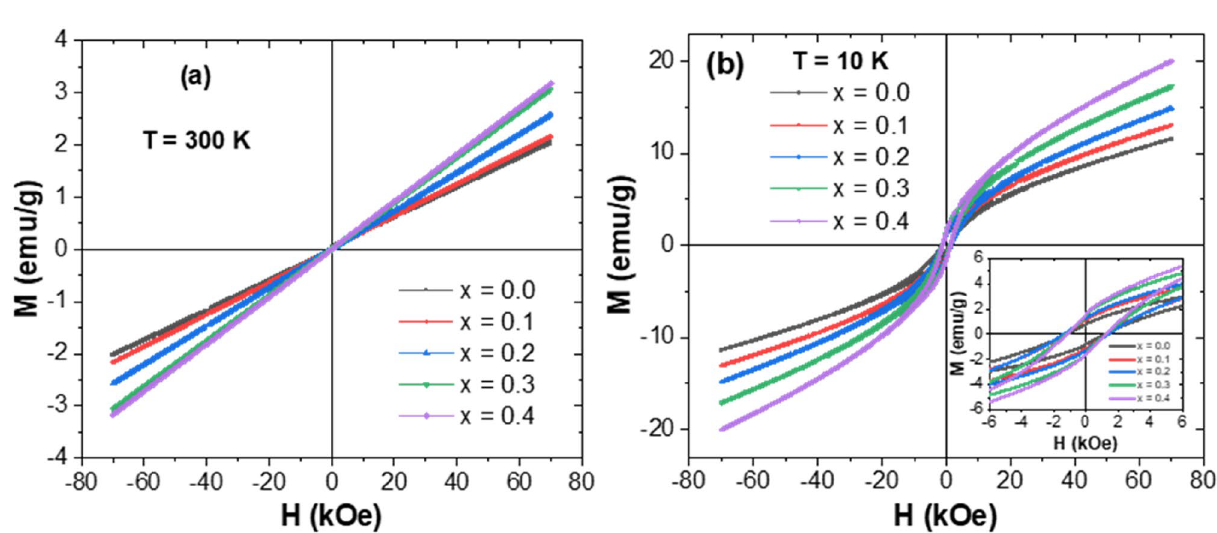
Figure 6. Magnetic hysteresis loops of V x -MnCo (x ≤ 0.4) MCs recorded at (a) T = 300 K and (b) T = 10